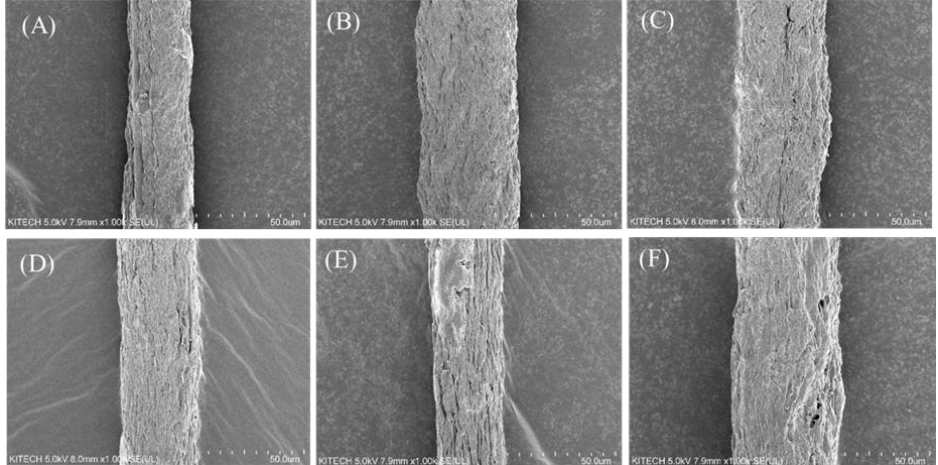
Figure 7. Surface and diameter of porcine/tilapia conjugated collagen fibers. ( A ) Porcine collagen 100% fiber with 31.3 (3.69) um averaged diameter, ( B ) porcine collagen 80% fiber with 37.3 (4.04) um averaged diameter, ( C ) porcine collagen 60% fiber with 39.3 (4.32) um averaged diameter, ( D ) porcine collagen 40% fiber with 35.7 (3.56) um averaged diameter, ( E ) porcine collagen 20% fiber with 31.5 (3.05) um averaged diameter, and ( F ) tilapia collagen 100% fiber with 50.1 (4.23) um averaged diameter. The scale of all figures is 50.0 um. At least 5 fibers were analyzed for each case with standard deviation.